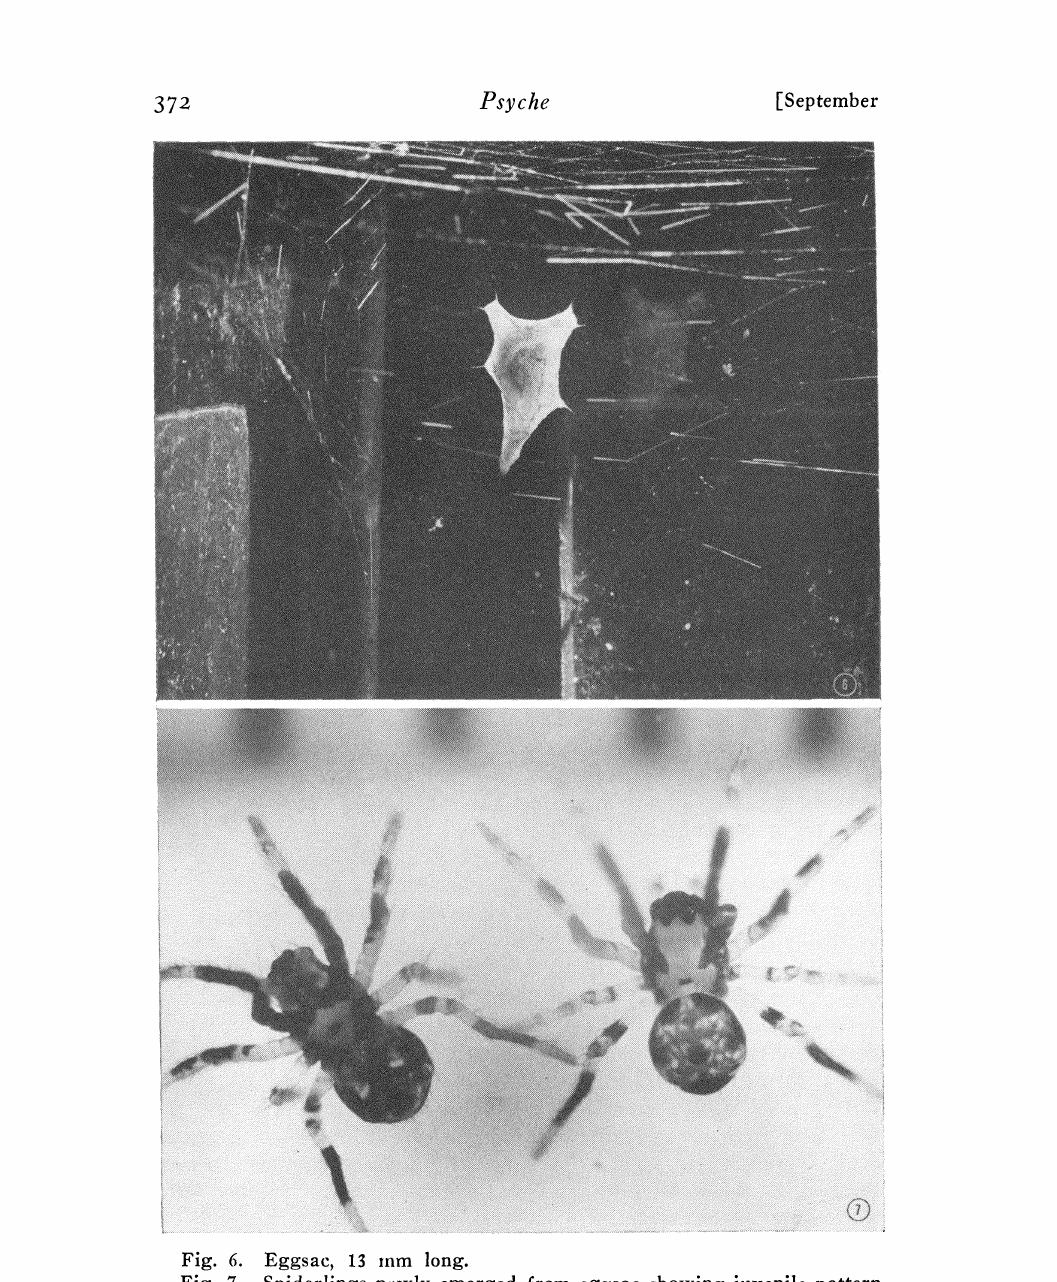
Fig. 6. Eggsac, 13 mm long. Fig. 7. Spiderlings newly emerged from eggsac showing juvenile pattern. Bars above are mm